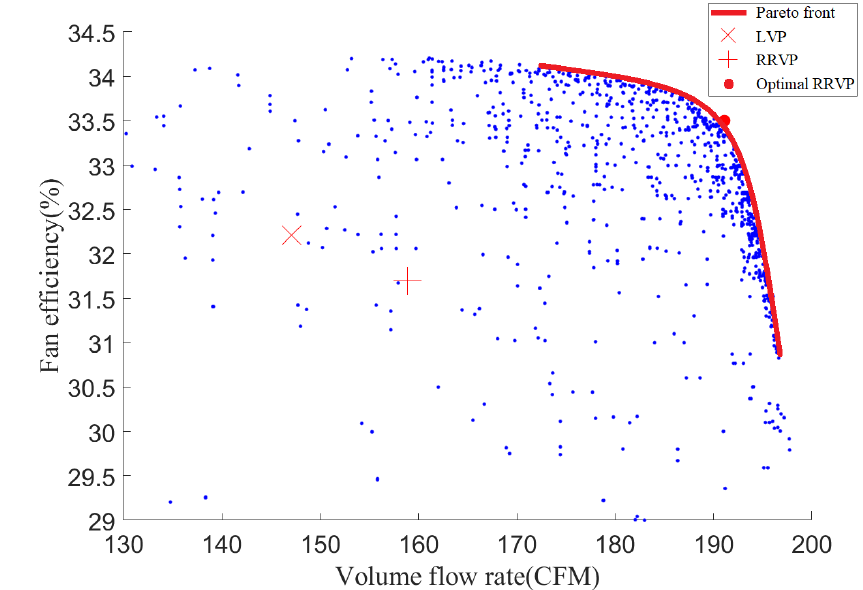
Figure 18. Pareto front and distribution of all results in optimization